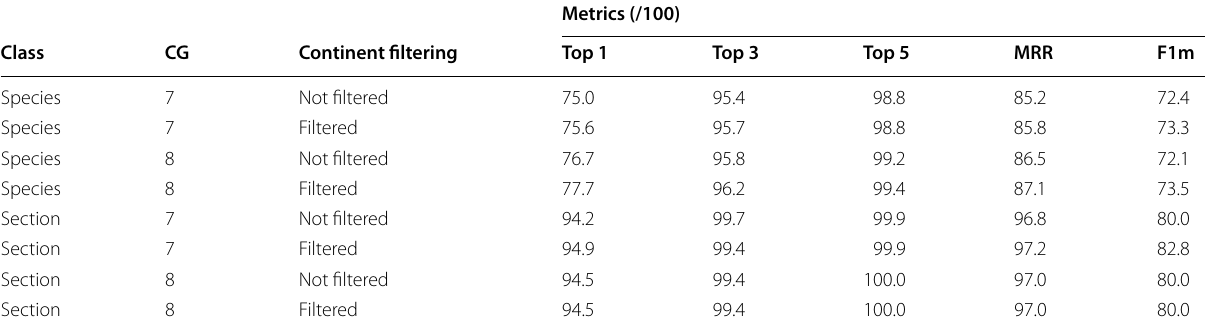
Table 7 Comparison of results where “continent filtering” was